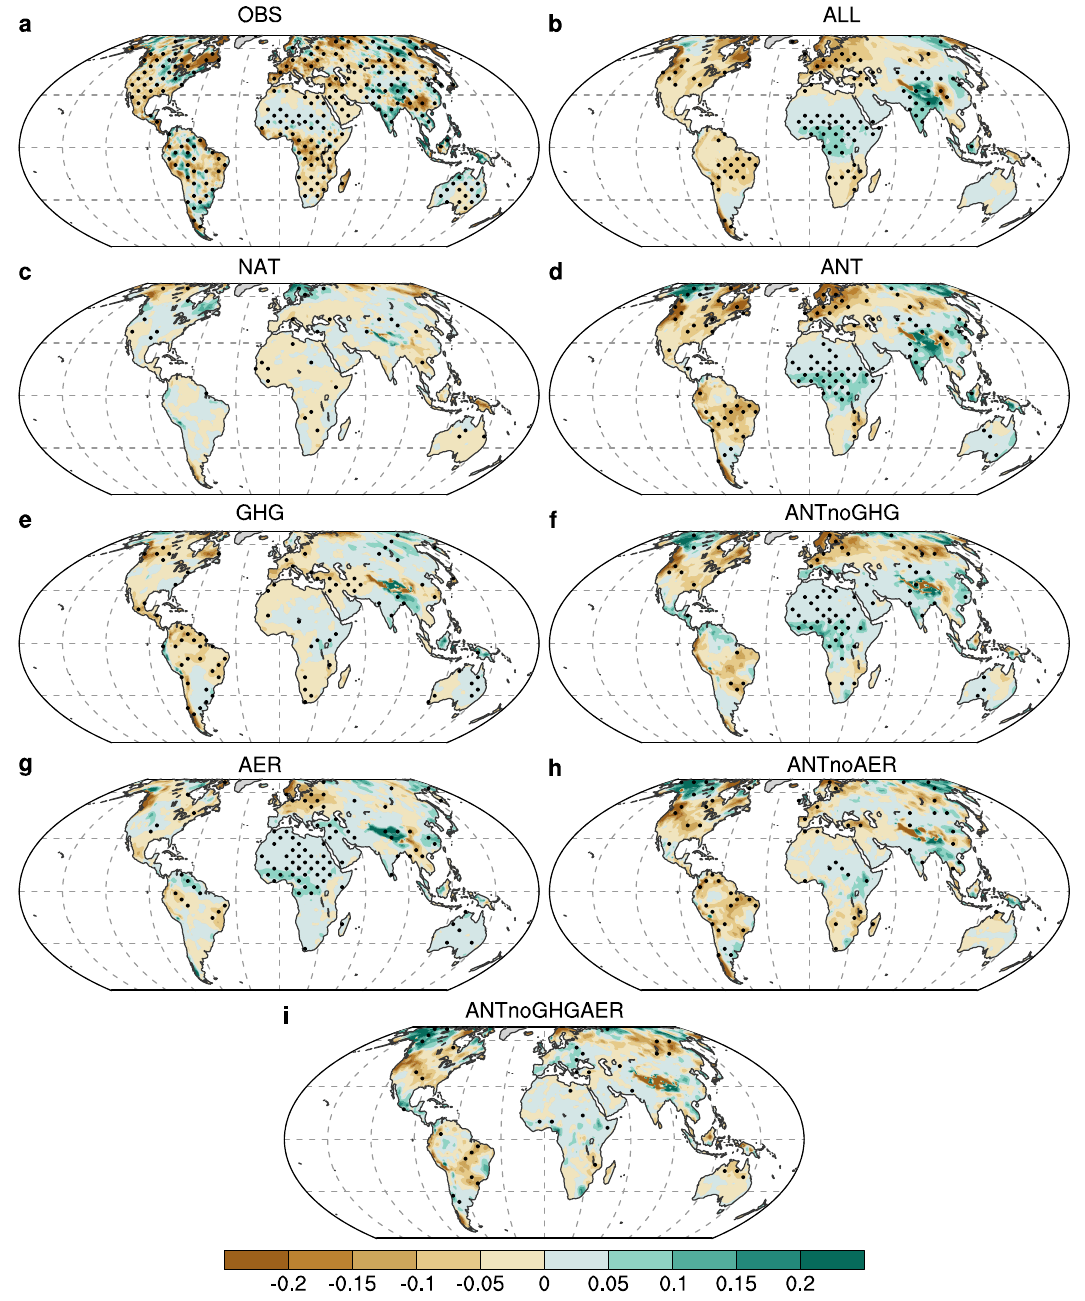
Fig. 1 Spatial distribution of AI trends for 1965 to 2014. Spatial distribution of the linear trends of 5-yr mean annual AI (per 50 yr) in the mean of observations (OBS) ( a ), and CMIP6 simulations with ALL ( b ), NAT ( c ), and ANT ( d ), GHG ( e ), ANTnoGHG ( f ), AER ( g ), ANTnoAER ( h ), and ANTnoGHGAER forcings ( i ). The dot indicates at least 70% of the simulation members agreeing on the direction of the trend at that